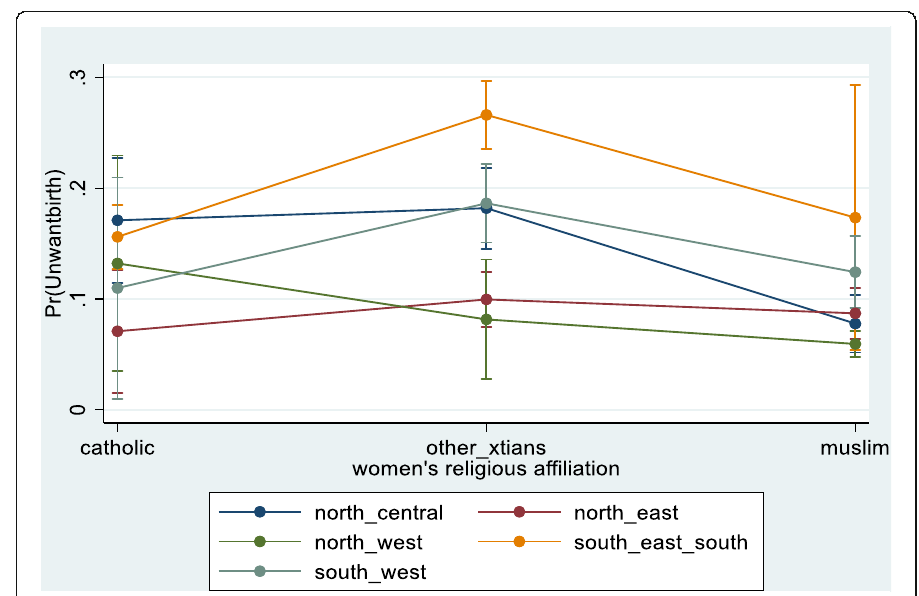
Fig. 1 Probability of women experiencing unintended pregnancy among women according to religion and region in Nigeria (NDHS,